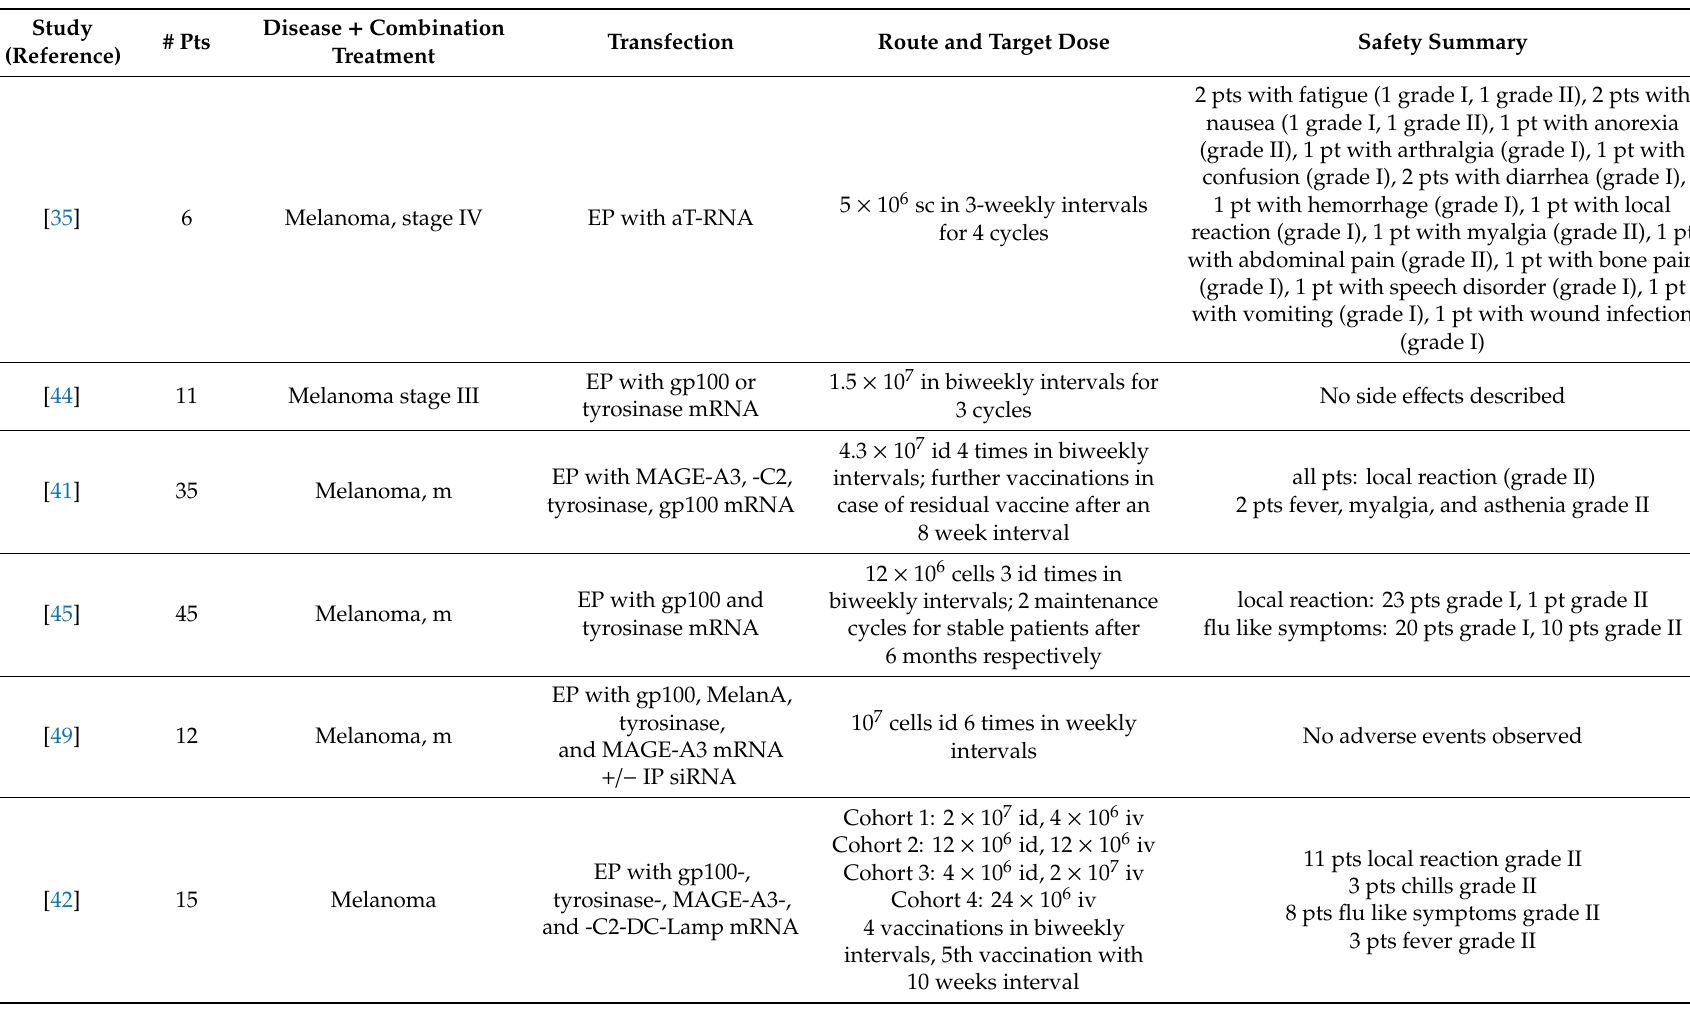
Table 3. Adverse events in trials using DCs loaded with